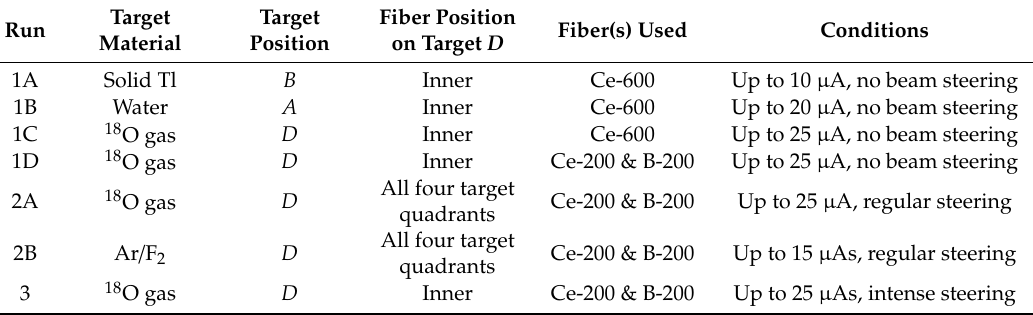
Table 2. List of Experiments. The fiber(s) were always installed on the gas target in position D , while not only target D but also A and B were irradiated. Only one fiber was read out at the time.